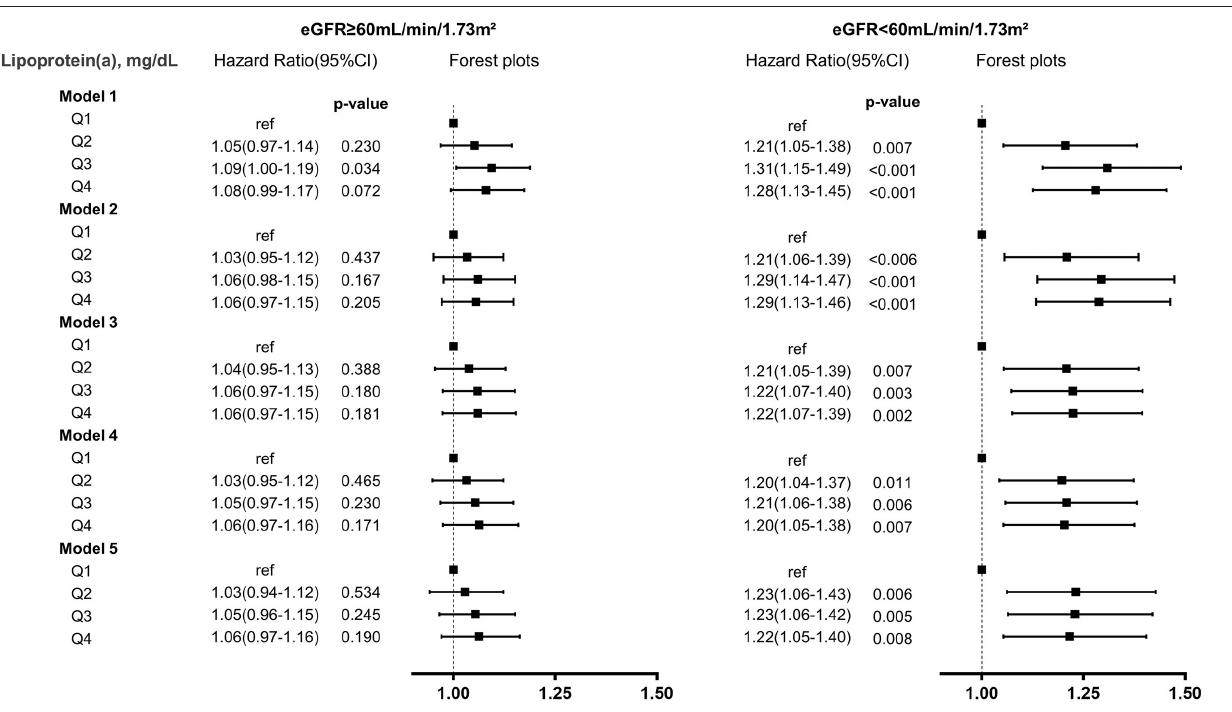
FIGURE 1 | Lipoprotein(a)-associated risk of all-cause mortality in different eGFR levels. model (1) unadjusted; (2) adjusted for demographic characteristics (gender and age); (3) adjusted for demographic characteristics, medical history (percutaneous coronary intervention, acute myocardial infarction, hypertension, diabetes mellitus, anemia, stroke, congestive heart failure, coronary artery disease, valvular heart disease, atrial fibrillation); (4) adjusted for demographic characteristics, medical history, and laboratory tests (low-density lipoprotein cholesterol, high-density lipoprotein cholesterol, triglycerides); (5) adjusted for demographic characteristics, medical history, laboratory tests, and medications (angiotensin-converting enzyme inhibitor or angiotensin receptor blocker, beta-blockers,